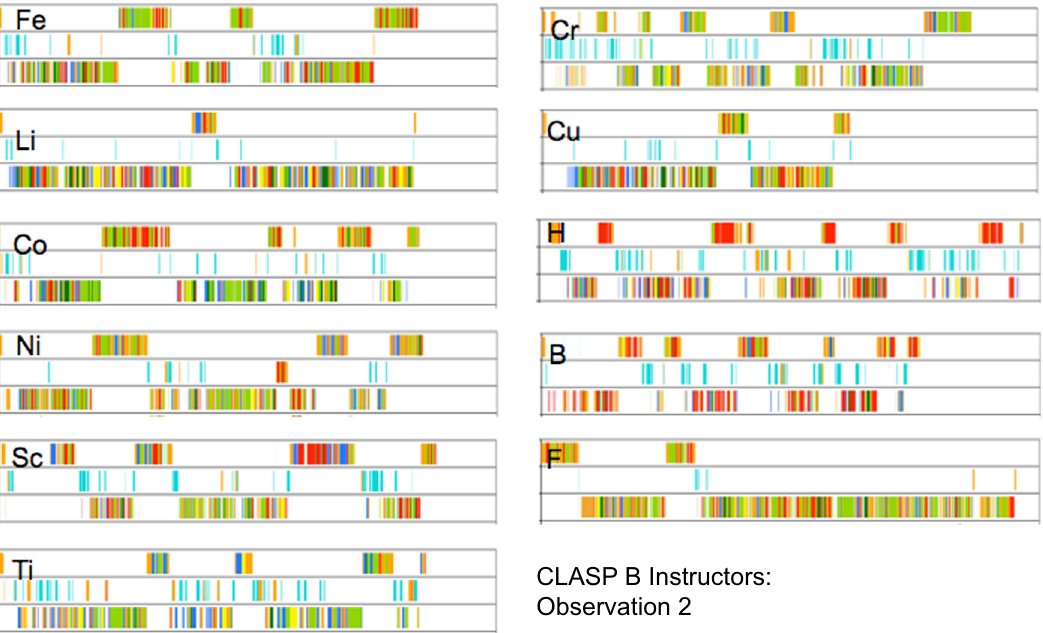
FIG. 8 (color online). Eleven different instructors teaching the same set of activities. The top row represents whole class time, the bottom row is small group time, and the middle row represents the interactions that take place during small group time, but when the instructor is addressing the class as a whole. Time is on the x axis. The colors are consistent with those in Fig.